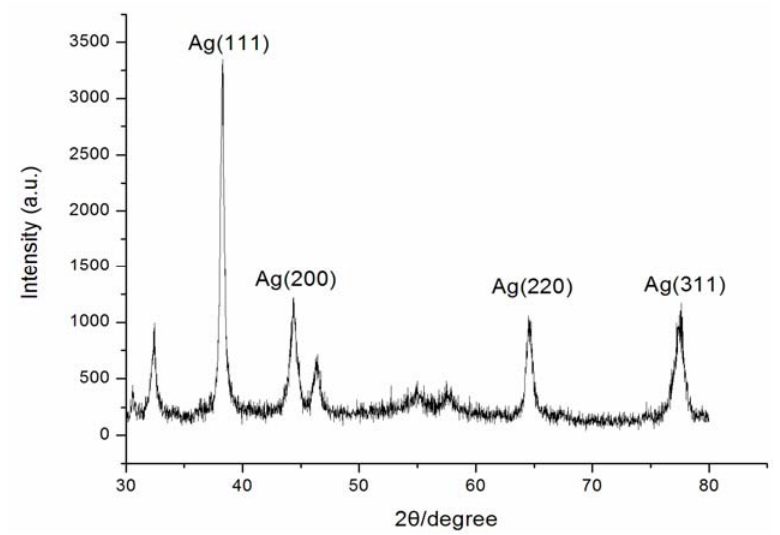
Figure 4. Representative X-ray diffraction patterns of AgNPs synthesized by Aspergillus terreus (a.u. = arbitrary